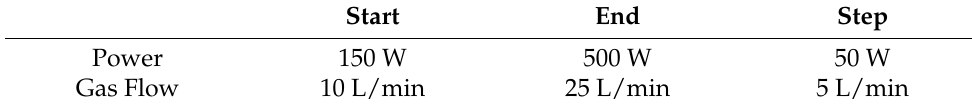
Table 3. Power and gas flow parameters.